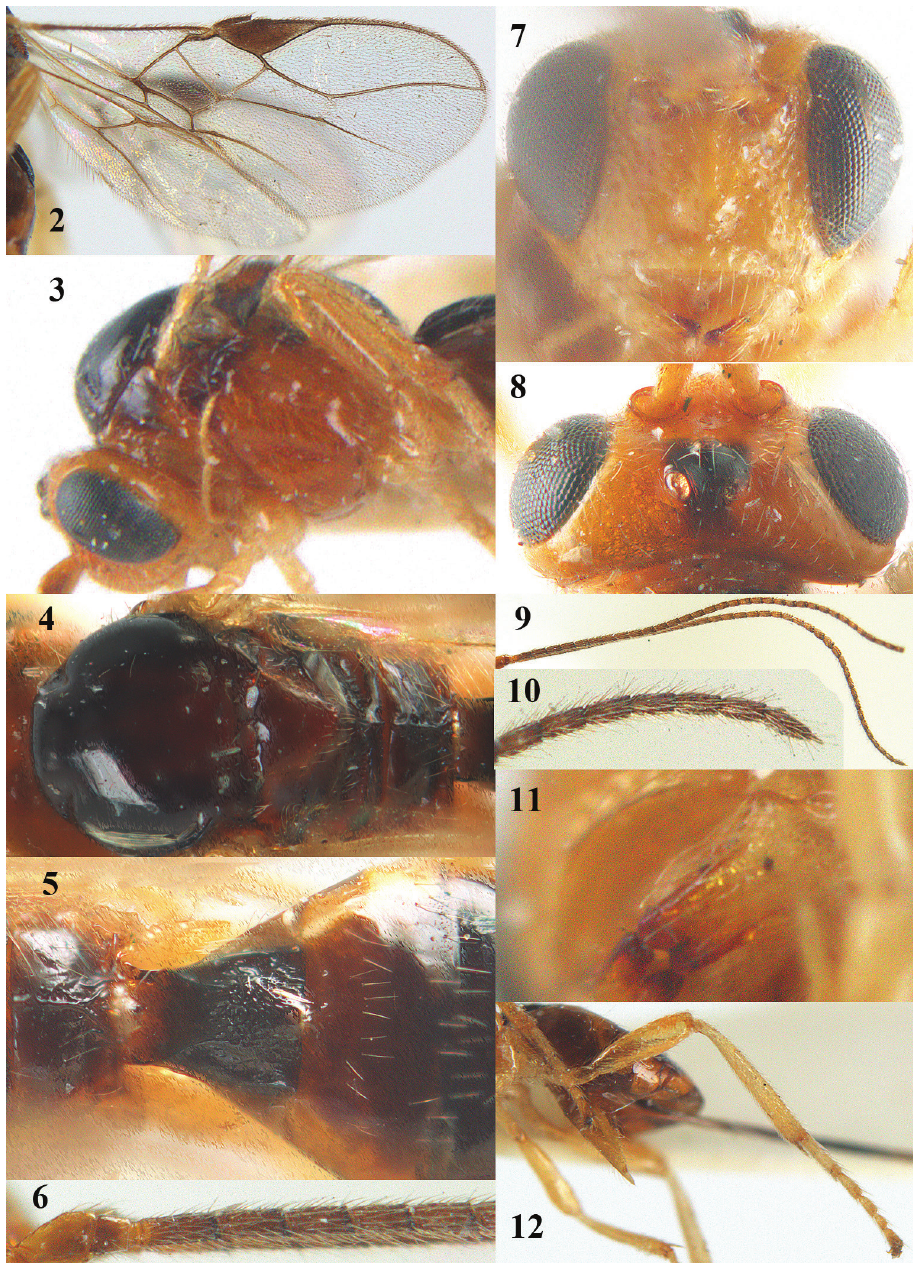
Figures 2–12. Psyttalia carinata (Thomson), ♀ , holotype of Opius brevitemporalis Tobias. 2 wings 3 head and mesosoma lateral 4 mesosoma dorsal 5 propodeum and first–third metasomal tergites dorsal 6 base of antenna 7 head anterior 8 head dorsal 9 antenna 10 apex of antenna 11 mandible lateral 12 hind leg and hypopygium